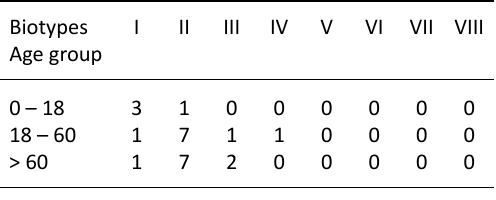
Table 4. Relation between biotypes and serotypes